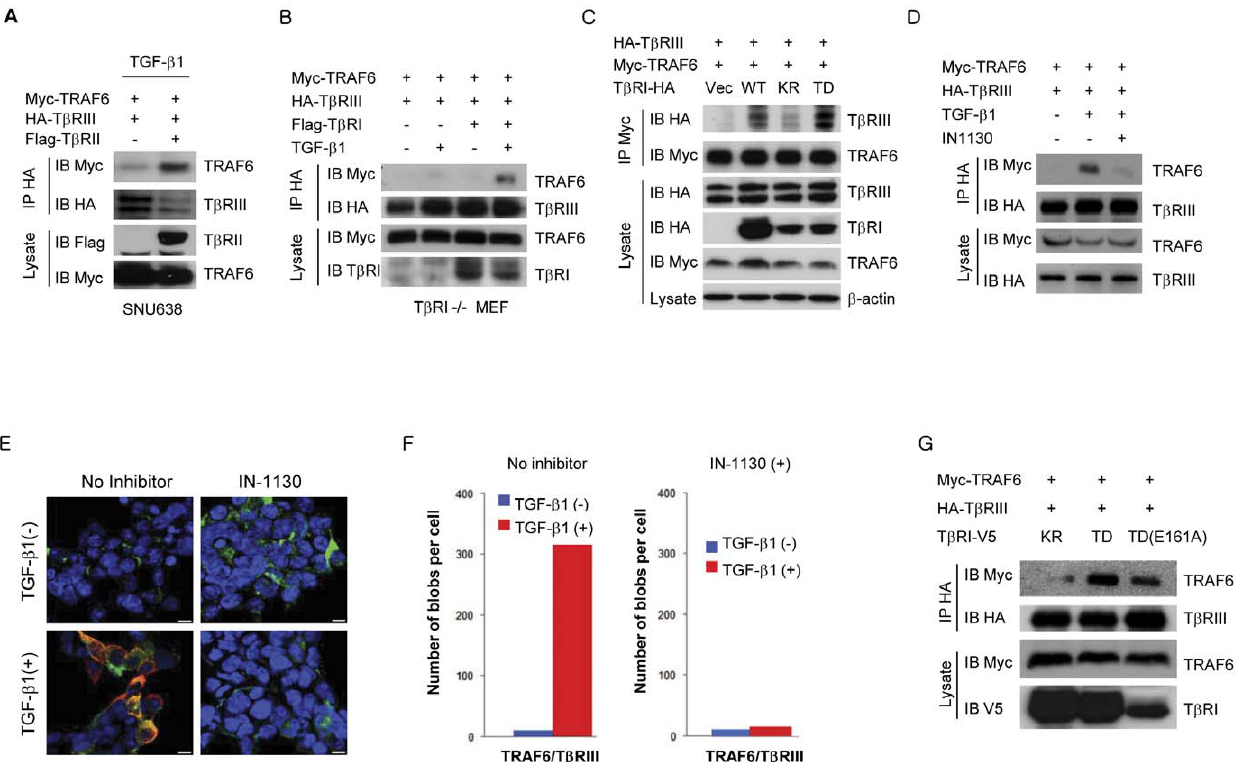
Figure 4. Association of TRAF6/T b RIII is regulated by functional T b RII and T b RI. ( A ) Myc-TRAF6, HA-T b RIII, and/or Flag-T b RII were expressed in SNU638 human gastric cancer cells and treated with TGF- b 1 for 60 min. Immunoprecipitation and immunoblotting were carried out to elucidate the requirement of T b RII for TRAF6/T b RIII interaction. ( B ) TRAF6 and T b RIII interaction in T b RI 2 / 2 MEFs in the presence or absence of exogenous T b RI expression. ( C ) TRAF6/T b RIII interaction in the presence of wild-type, kinase inactive (KR: K232R), and constitutively active (TD: T204D) T b RI in HEK293 cells. ( D ) Interaction between TRAF6 and T b RIII in the presence of IN-1130 (0.1 m M), a specific inhibitor of T b RI kinase. ( E ) Olink assay for TRAF6 and T b RIII interaction in the presence of TGF- b and/or IN-1130. Transfected cells were counterstained with Alexa 488-labeled HA antibody to HA-T b RIII (green), and the nuclei were stained with Hoechst 33342 (blue). Bar=2.5 m m. ( F ) The number of in situ PLA signals (red blobs) per cell was counted by semi-automated image analysis. ( G ) Co-immunoprecipitation analysis was conducted to elucidate the function of T b RI in TRAF6/T b RIII interaction. T b RI mutants KR, TD, and TD (E161A) mutated in TRAF6 consensus binding motif in T b RI (TD) were used. The results are representative of three independent experiments. (Figure 5B), and then performed a T b RI (TD) kinase assay. As shown in Figure 5D, T b RI (TD) was able to phosphorylate GST- T b RIII-C and mutants S826A, S830A, and S834A, but was unable to phosphorylate mutant S829A, indicating that residue